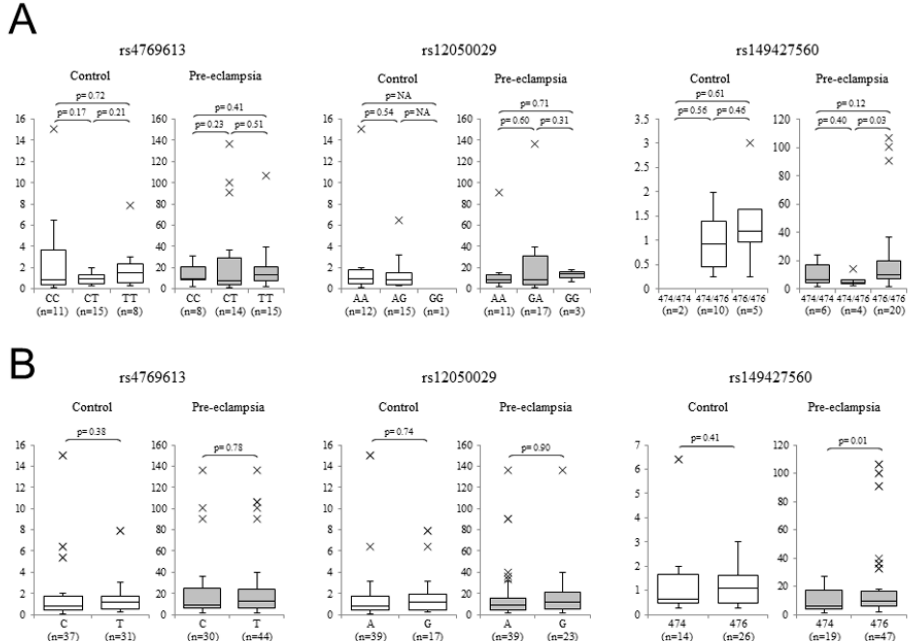
Figure 4. Correlations between MG828507 expression and the indicated genetic variants. ( A ) Comparison of the placental mRNA levels by variant genotype. Data for rs4769613 (left), rs12050029 (center), and rs149427560 (right) are shown. In each panel, data for the normotensive placental controls are shown on the left, and those from pre-eclamptic cases are shown on the right. ( B ) Comparison of the placental mRNA levels by variant allele type. The boxes indicate the 25th and 75th percentiles. The bands near the middle indicate the median values. The bars indicate the 1.5 interquartile ranges, with the outliers specifically marked. Sample numbers and p values are shown in each panel.